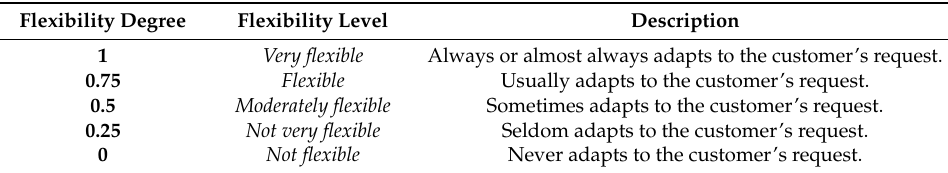
Table 7. Provider flexibility scale.